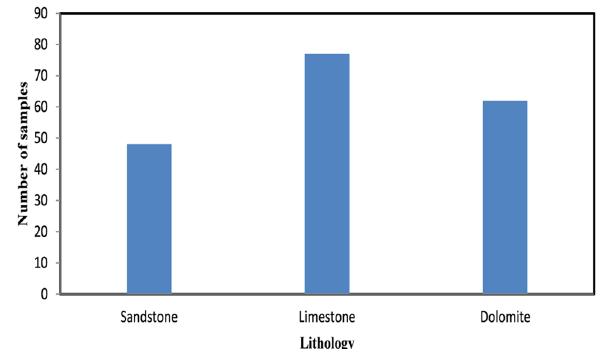
Fig. 3 Lithology distribution of the samples